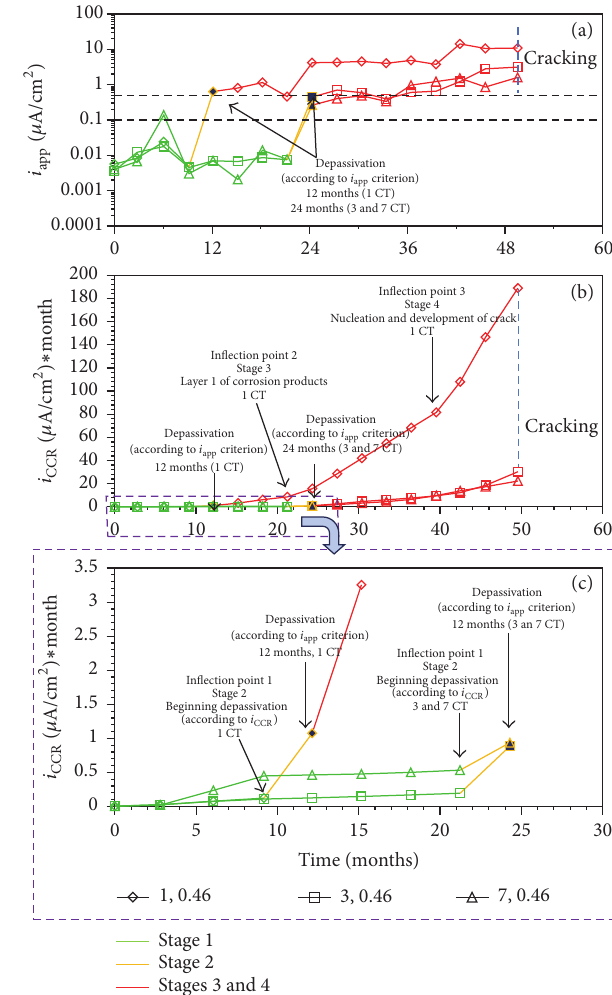
Figure 6: (a) Average 𝑖 app and (b and c) 𝑖 CCR versus exposure time, w/c ratio = 0.46, and three